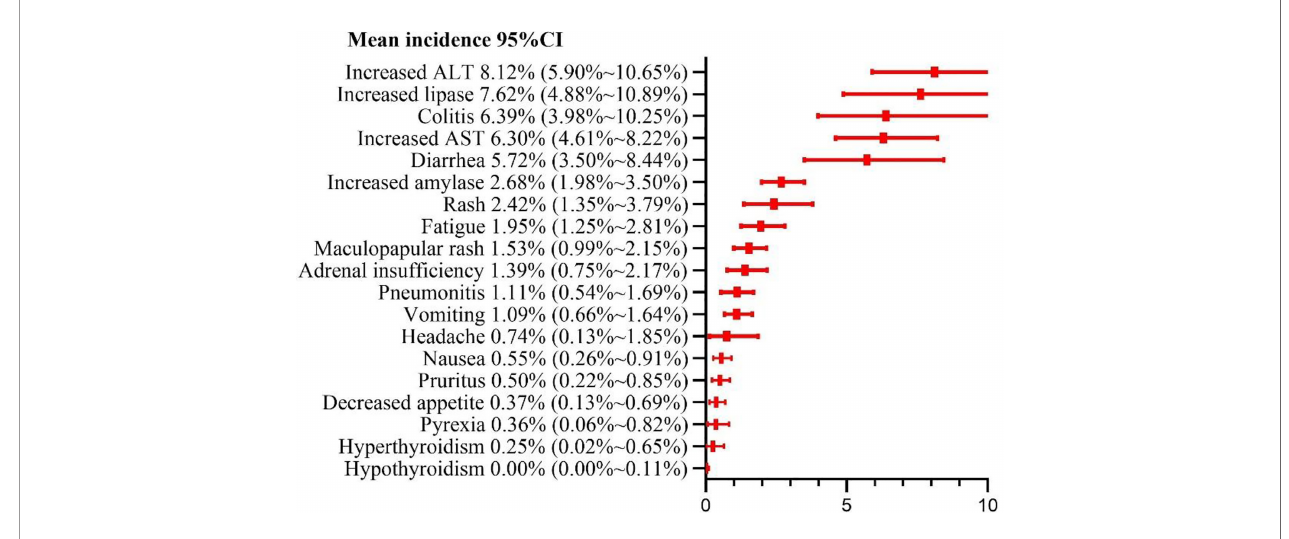
FIGURE 7 | Risk ratio of grade 3 or higher adverse events.